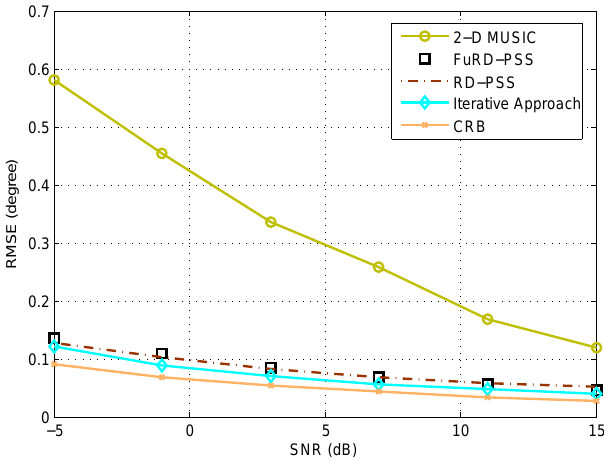
Figure 3. RMSE comparison of different methods versus SNR.